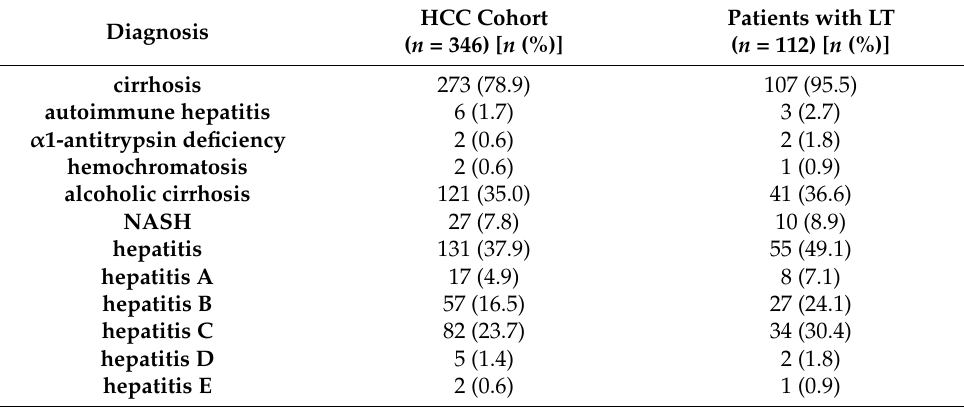
Table 1. Underlying disease of liver degeneration in the entire HCC and the LT cohort.